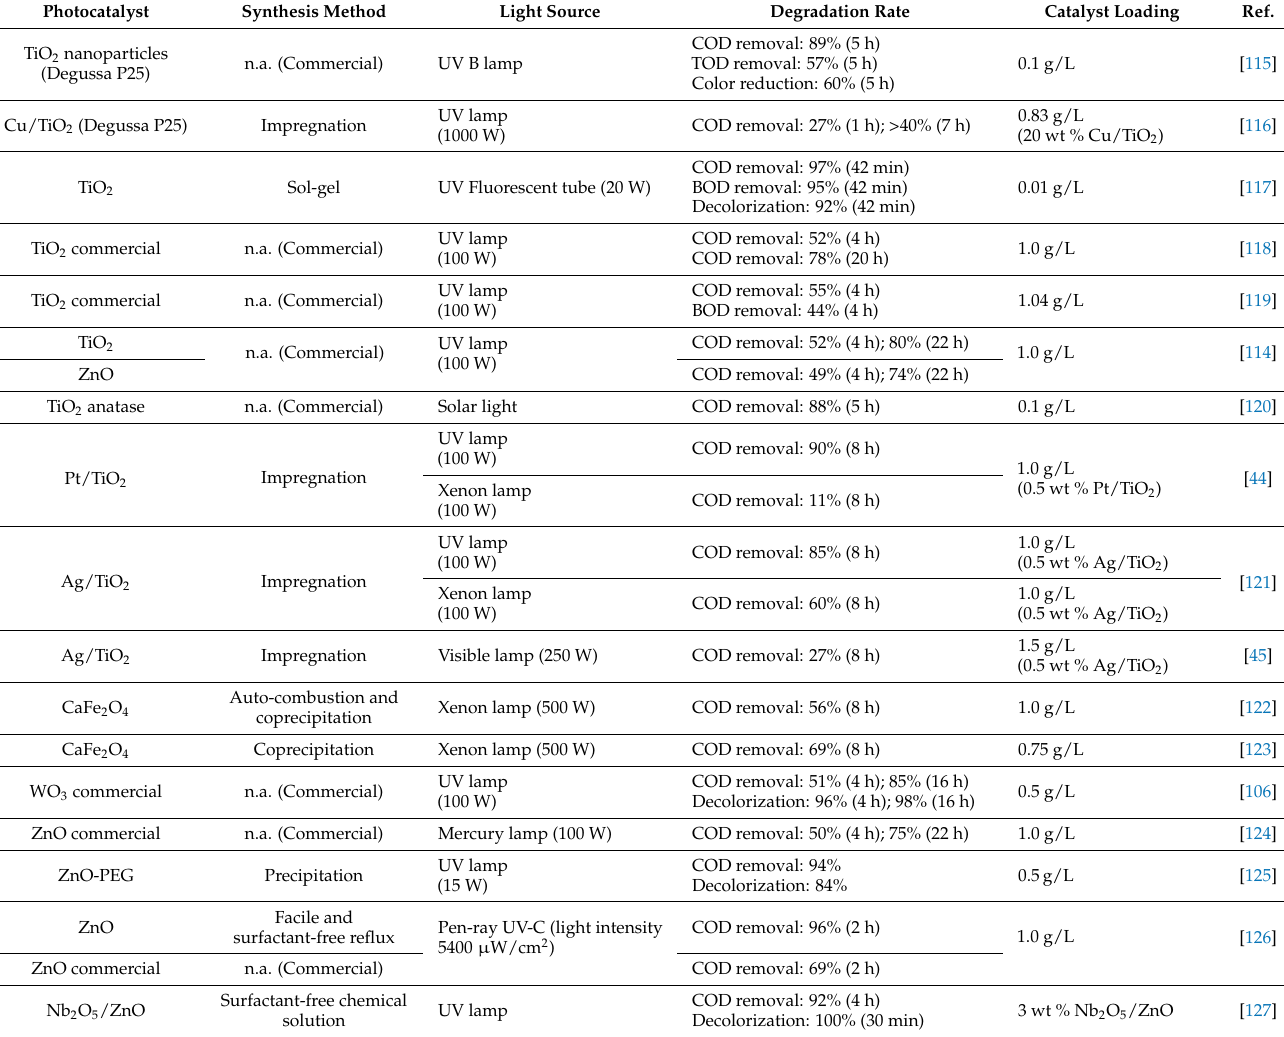
Table 4. Previous studies of photocatalytic technology for degradation of POME